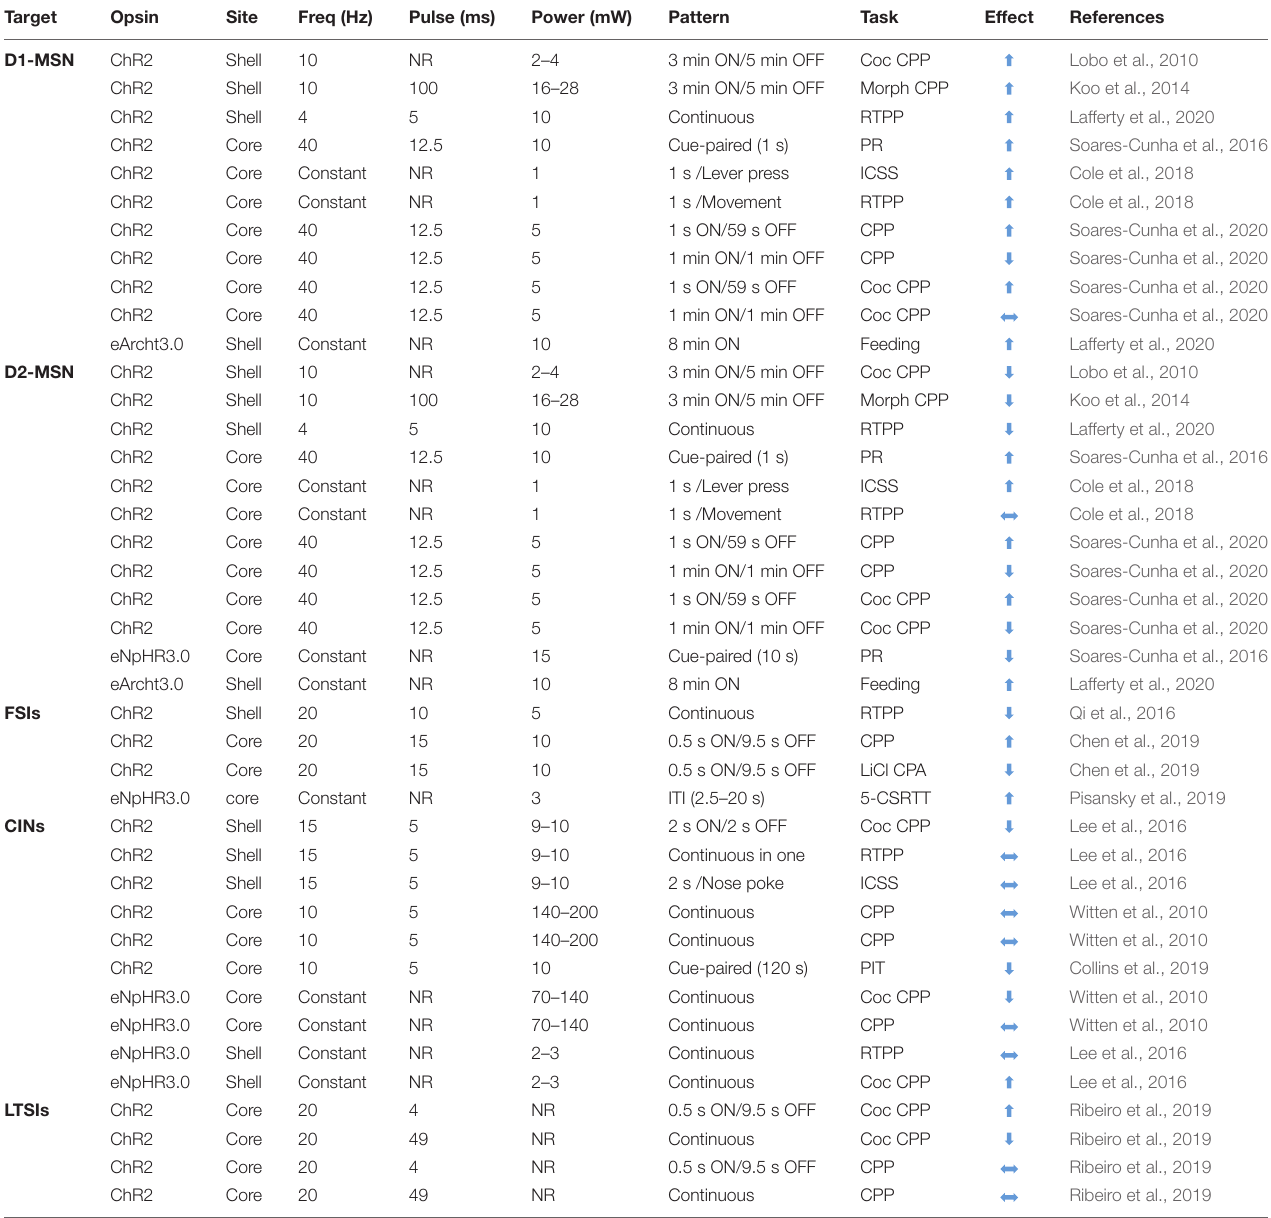
TABLE 1 | Optogenetic manipulations of NAc